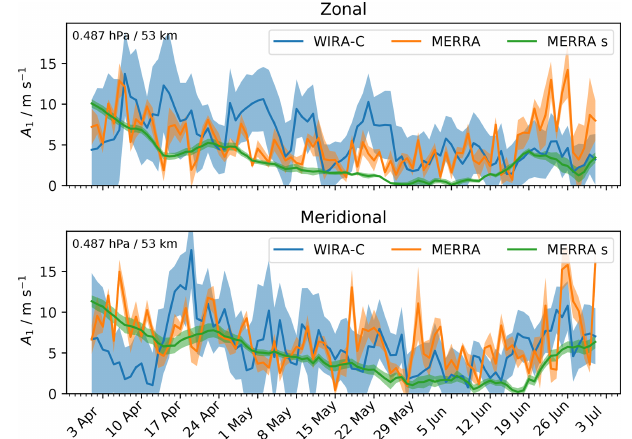
Figure 6. Time series of zonal and meridional diurnal tide am- plitudes during the tropical campaign for measurements (WIRA- C), MERRA-2 reanalysis (MERRA) and reanalysis smoothed (MERRA s) at an altitude level of 53km with corresponding errors of the model fit as shaded area.